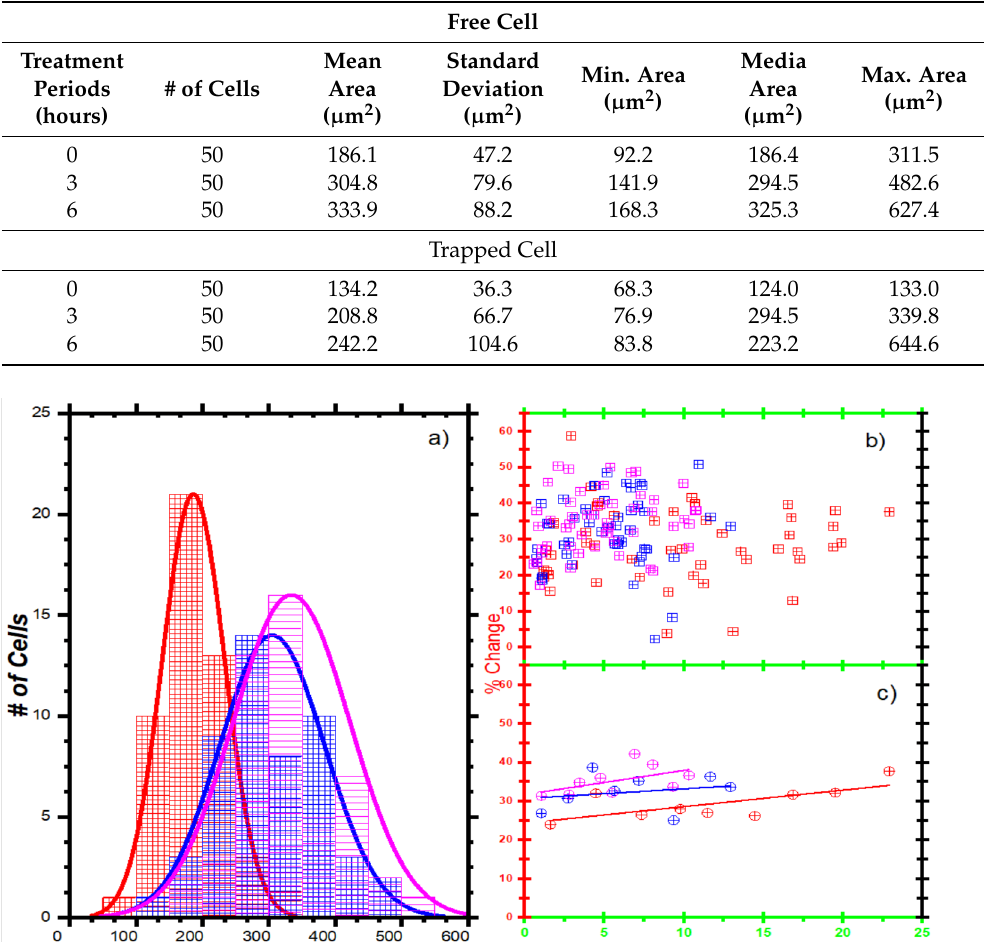
Table 1. The values of the essential statistical parameters of the area of the untreated and treated A549 lung cells free and trapped at 300 mW.